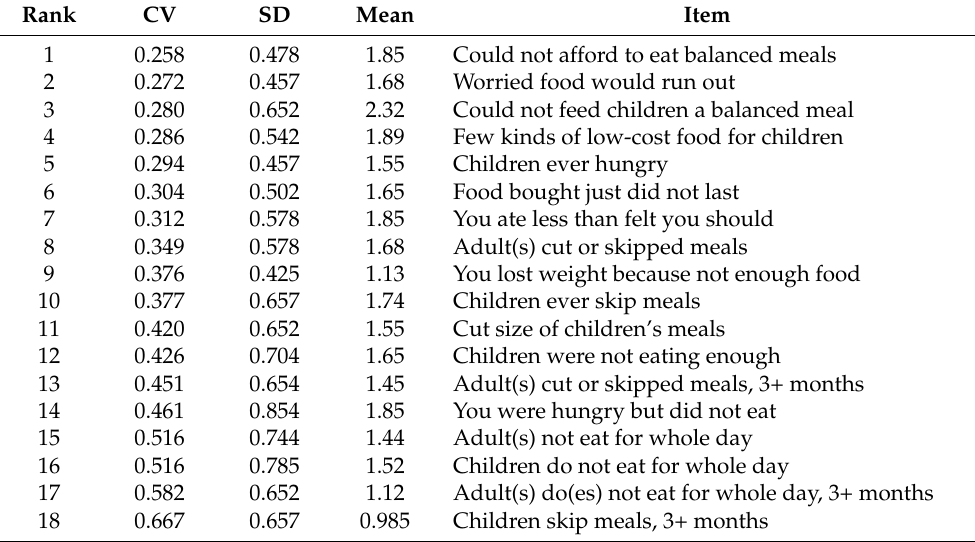
Table 3. Prioritizing the items of household food security.